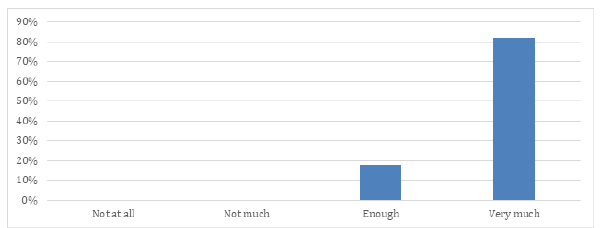
Figure 11. Level of satisfaction of the virtual experience